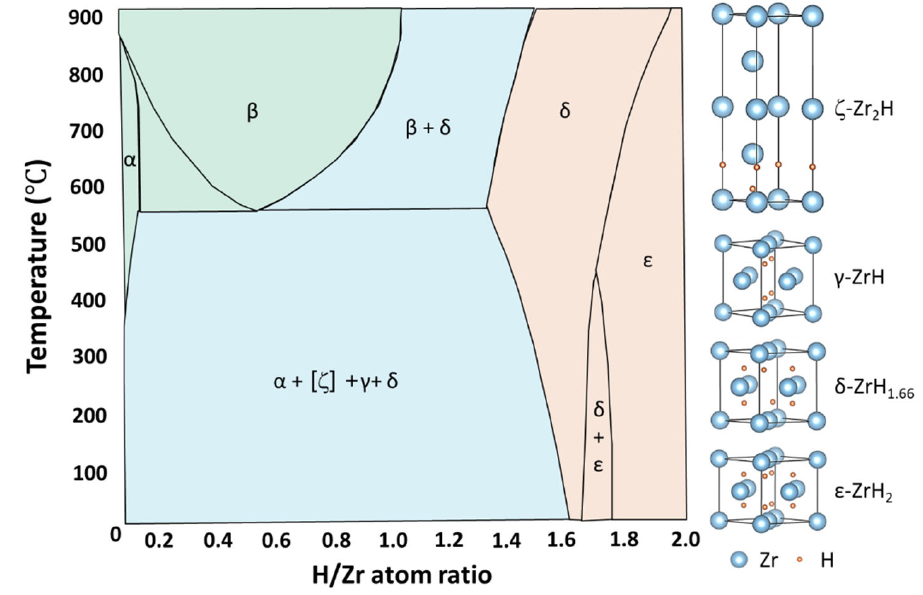
Figure 2. Zr-H phase diagram [3] and the unit cells of ζ -Zr 2 H, γ -ZrH, δ -ZrH 1.5 , and ε -ZrH 2 [21,22].